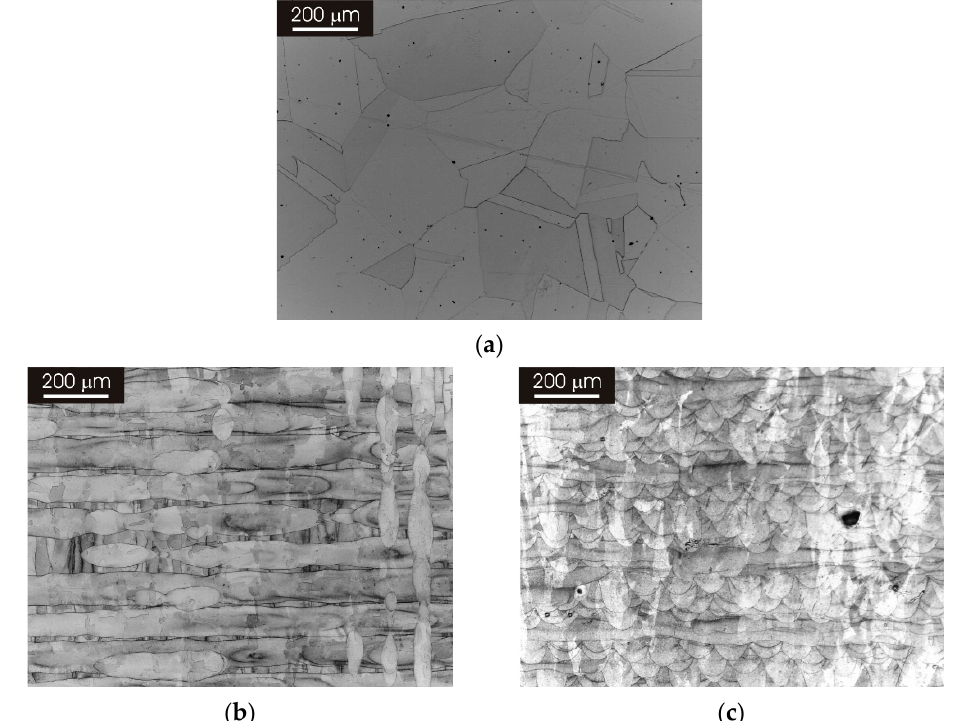
Figure 1. Optical micrographs of 316L stainless steel. ( a ) Wrought condition; ( b ) after 3D printing by L-PBF in the XY direction; ( c ) after 3D printing by L-PBF in the XZ direction.